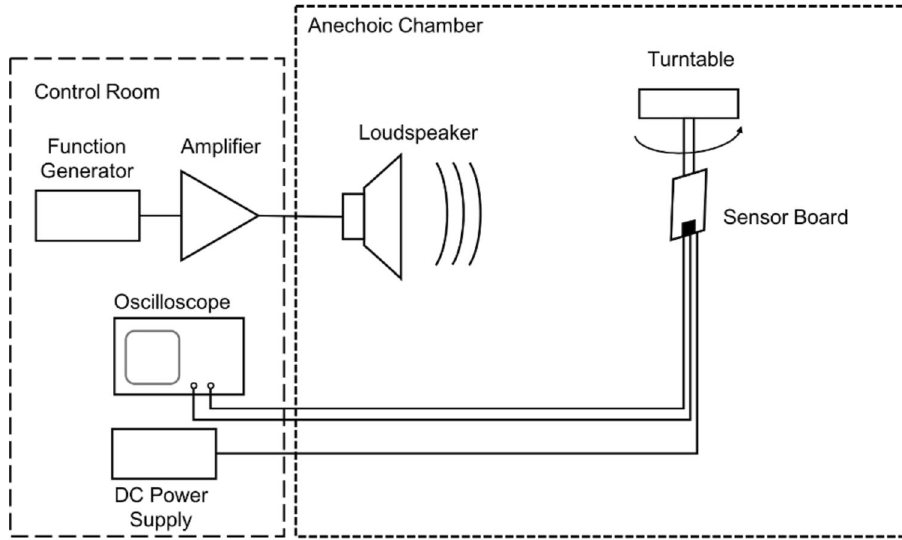
Figure 6. Frequency response and directionality setup diagram. Sensor board was attached to a turntable placed inside an anechoic chamber. A loudspeaker facing the turntable was utilized as the acoustic source. Sensor power supply, signal generating equipment and sensor signal reading instrumentation, represented here by an oscilloscope, were kept in the control room. For frequency response measurements, the signal was frequency-swept while keeping the sensor board fixed with respect to the source. For directionality, a single tone signal was applied while changing the angular position of the sensor with respect to the loudspeaker.